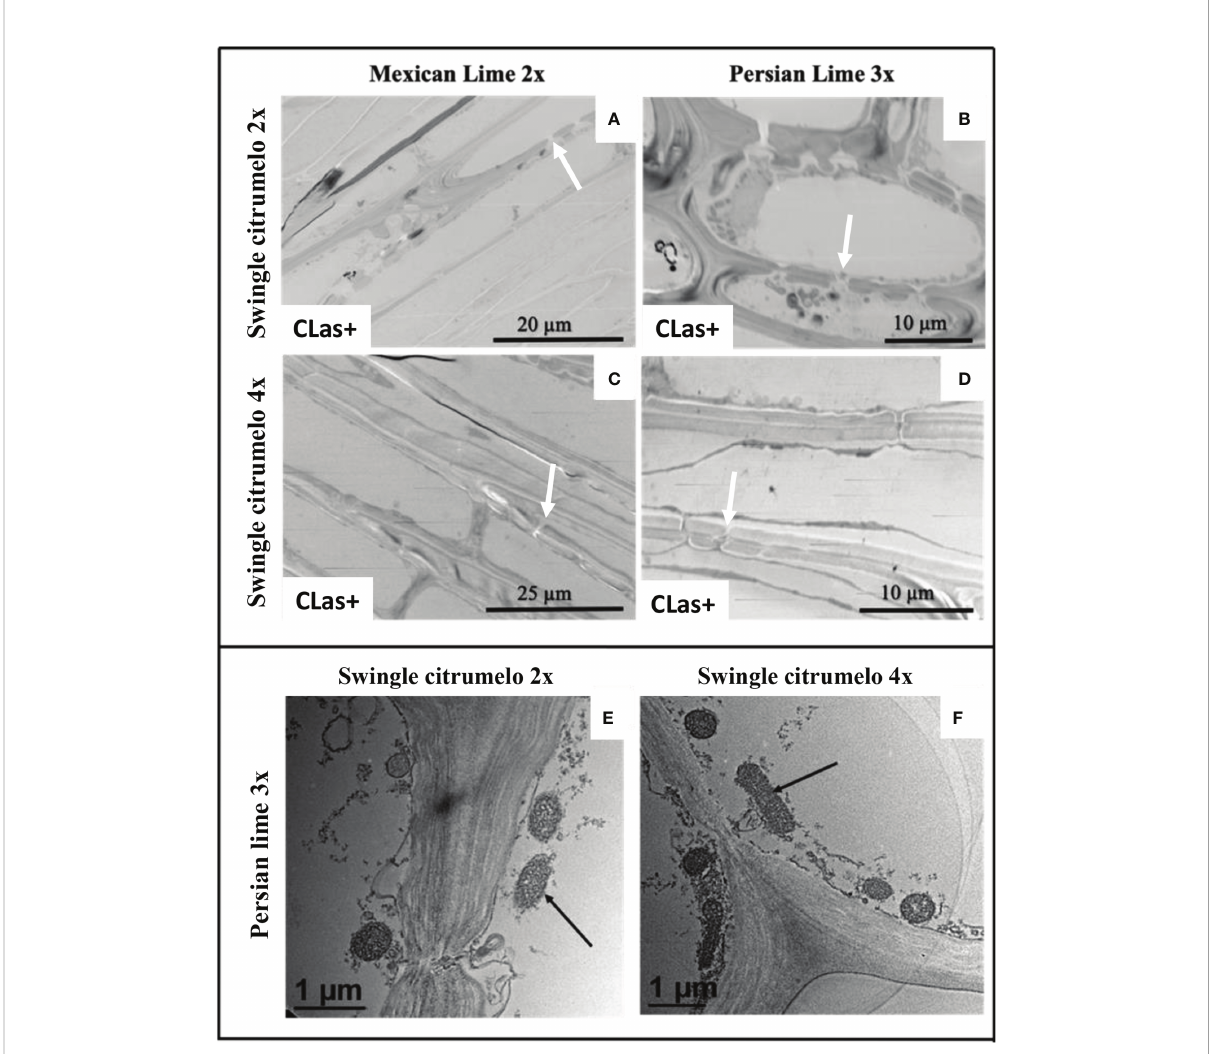
FIGURE 4 Transmission electron microscopy of phloem sieve plate in 2x (A, B) and 4x (C, D) roots of Swingle citrumelo grafted with Mexican lime and Persian lime infected (CLas+) by CLas. White arrows in pictures (A-D) indicate pores in the cell wall that are opened and not plugged by callose (A – C) . Visualization of CLas (black arrows) in 2x (E) and 4x (F) CLas+ root samples of Swingle citrumelo grafted with Persian